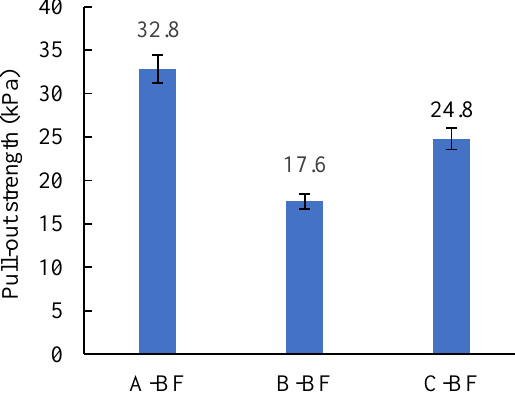
Figure 8. Pull-out strength of the basalt fiber asphalt mastic.